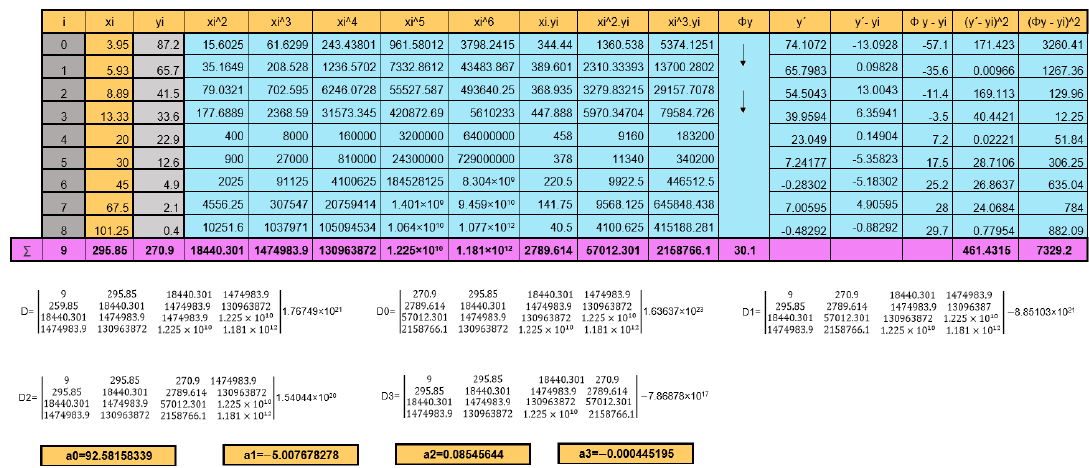
Figure 9. Demonstration of data calculation by the least-squares method (MS Excel).